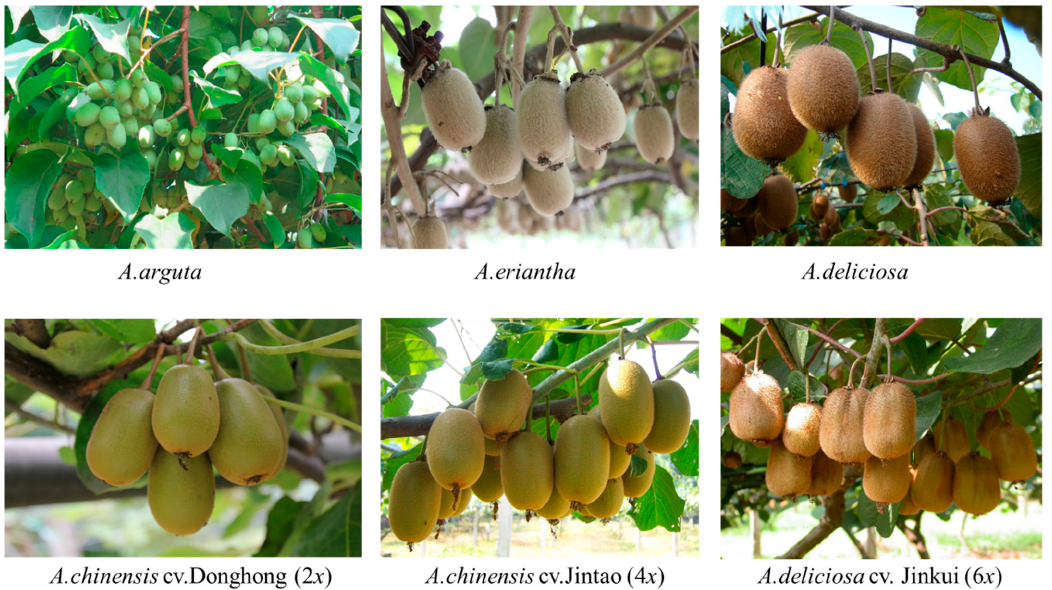
Figure 1. Kiwifruit experimental material for photosynthesis measurement.